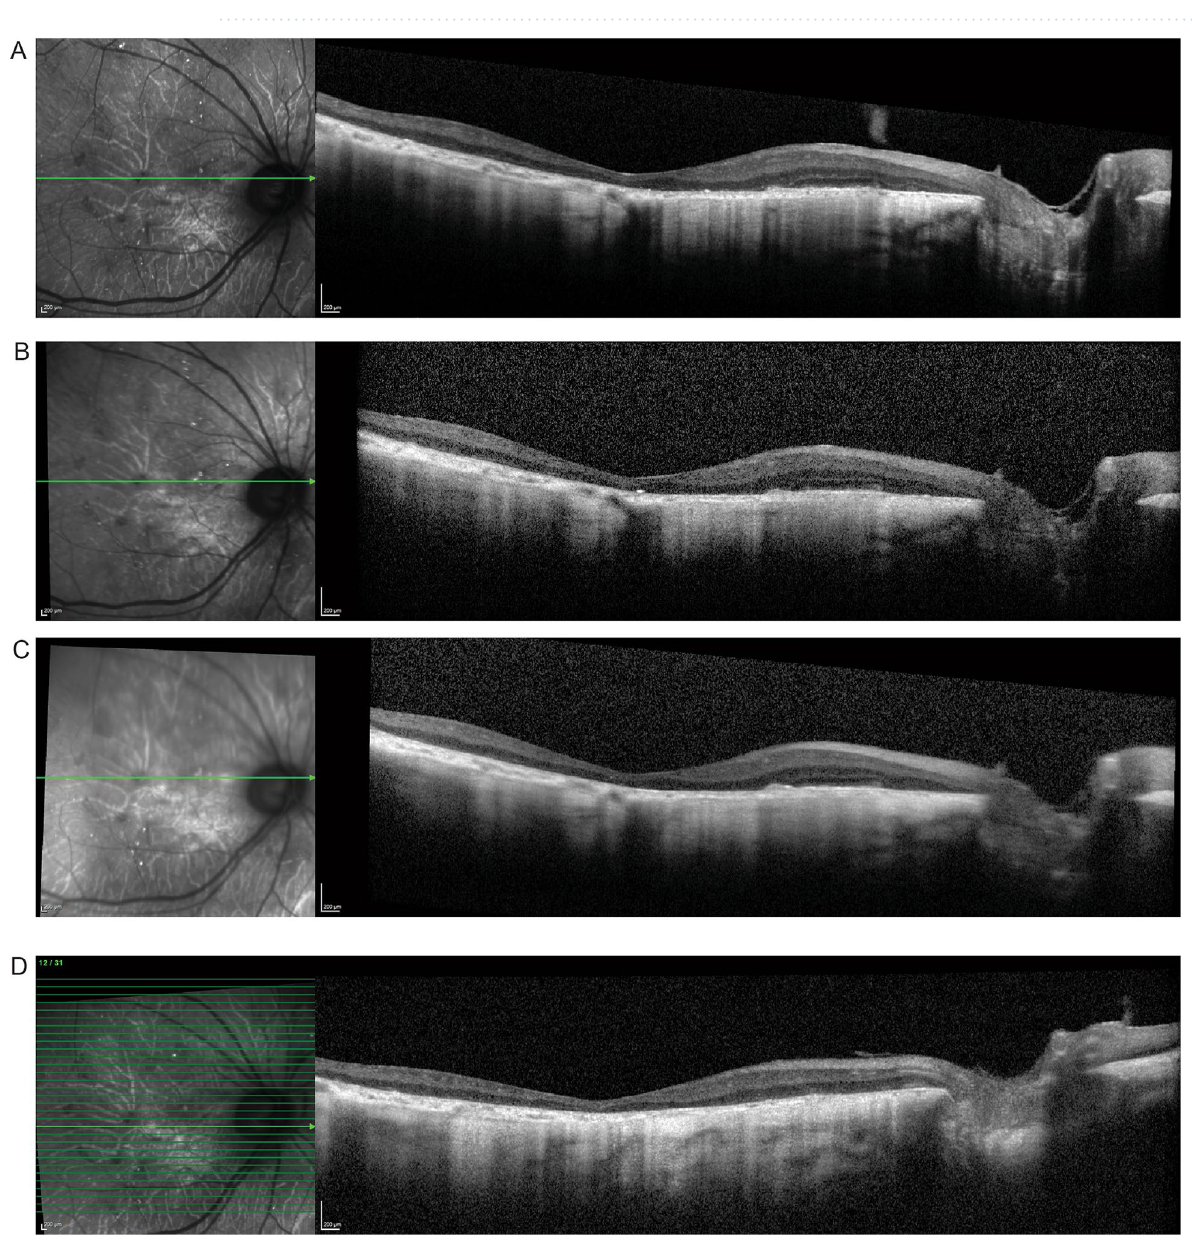
Figure 7. Spectral domain-optical coherence tomography (SD-OCT) for P3. The green line in each IR-R image indicates the position of the SD-OCT scan. ( A ) The horizontal scan through the fovea of the right eye for P3 at initial presentation ( B ) at 3-month follow up visit ( C ) at 6-months and ( D ) a 3-year follow up visit showing absence of EZ band, loss of the retinal layer structures and progressive decrease of foveolar